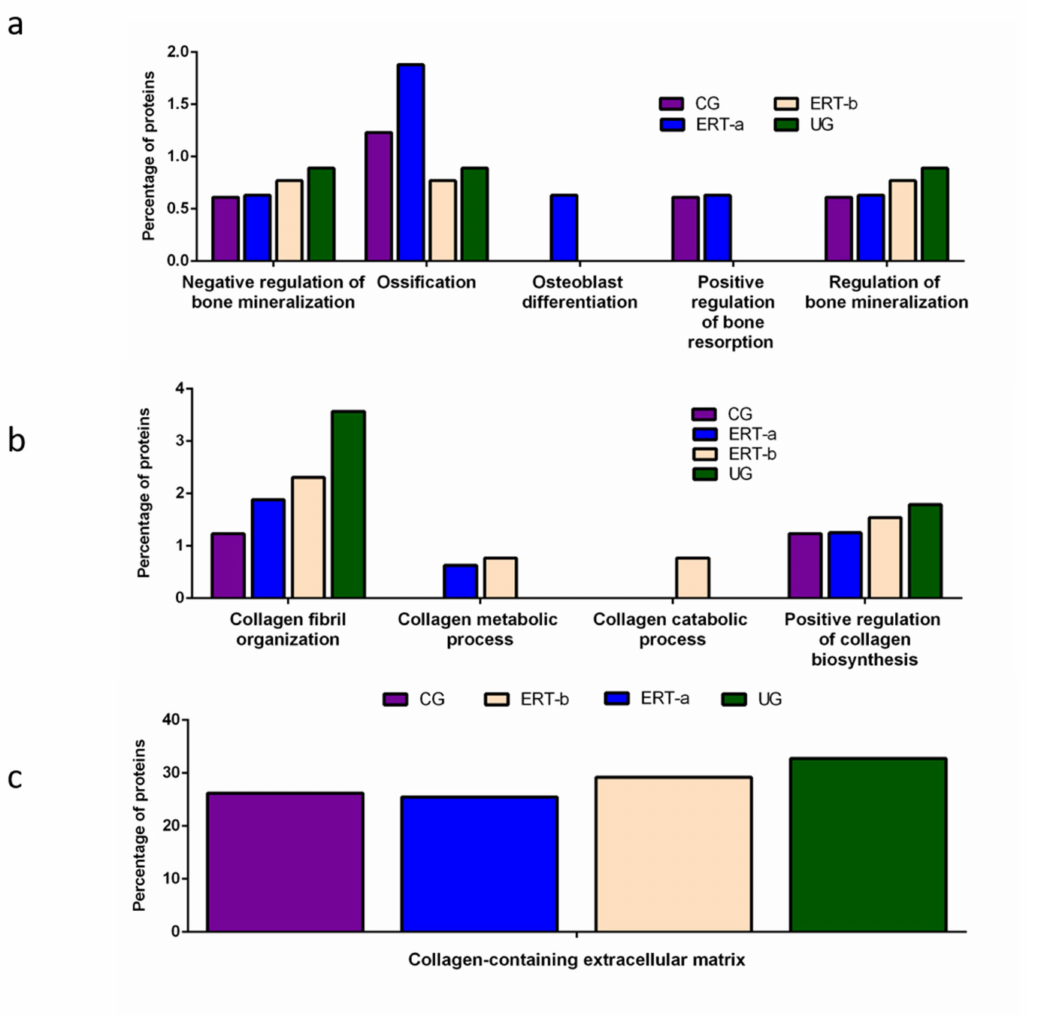
Figure 4. Functional enrichment analysis using FunRich. Proteins identified in each the different groups were submitted to molecular functional analysis according to their involvement in: ( a ) processes that occur at the bone level; ( b ) collagen function (activity/processing/biosynthesis); ( c ) collagen-containing extracellular matrix. CG, control group; ERT-a, patients sampled before ERT; ERT-b, patients sampled 24 h after ERT; UG, untreated group. Proteins included in this analysis, identified in the qualitative proteomic analysis, are listed in the Supplementary Table